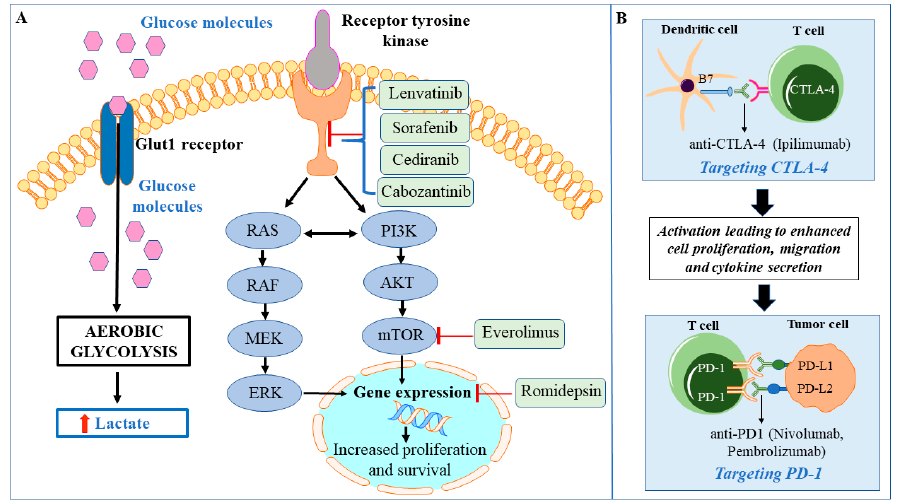
Figure 2. Model depicting the drug targets in Hürthle cell thyroid cancer that are being exploited in the ongoing clinical trials. ( A ) The inhibitory molecules acting upon various oncogenic pathways are shown in the green box. ( B ) Diagrammatic representation of the mechanism of action of various immunotherapy agents currently employed in clinical trials for Hürthle cell thyroid cancer.